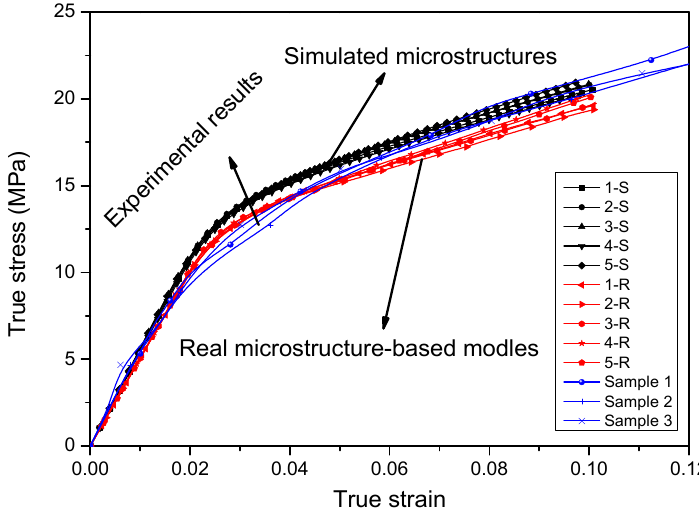
Figure 8. Comparison between simulated stress–strain curves and experimental results.